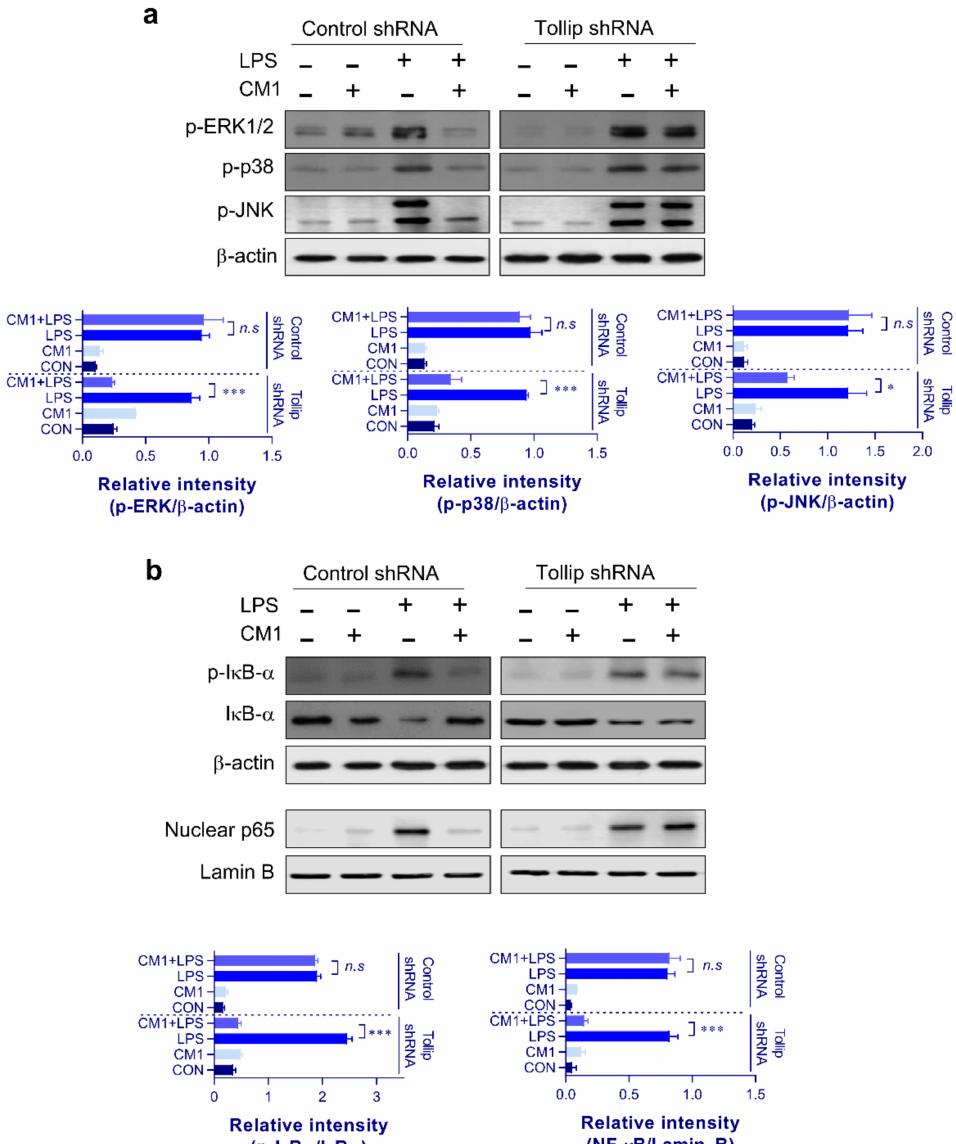
Figure 5. Tollip is indispensable for the inhibitory action of CM1 on MAPKs and NF- κ B signaling in LPS-treated RAW264.7 cells. Control and Tollip shRNA-transfected RAW264.7 cells were incubated with CM1 (2 µ g/mL) for 1 h and then treated with LPS (200 ng/mL) for 24 h. Control and Tollip shRNA-transfected RAW264.7 cells were pretreated with CM1 (2 µ g/mL) for 1 h and then treated with LPS (200 ng/mL) for 45 min. Cytosolic fractions were analyzed to determine the p-ERK, p- p38, p-JNK, p-I κ B- α , I κ B- α , and β -actin protein levels using specific Abs ( a ). Nuclear fractions were analyzed to determine the p65 NF- κ B and lamin B protein levels using specific Abs ( b ). One representative plot from among three independent experiments is shown. Statistical analysis was performed by one-way ANOVA in conjunction with Tukey’s multiple test; n.s : no significance, * p < 0.05, and *** p < 0.001. Abbreviations: Tollip, Toll-interacting protein; LPS, lipopolysaccharide; shRNA, short hairpin RNA; p-ERK1/2, phosphor-extracellular signal-regulated kinase-1/2, p-p38, phosphor-p38; p-JNK, phosphor-c-Jun N-terminal kinase; I κ B, inhibitor of κ B; p-I κ B, phosphor-I κ B; Abs, antibodies; NF, nuclear